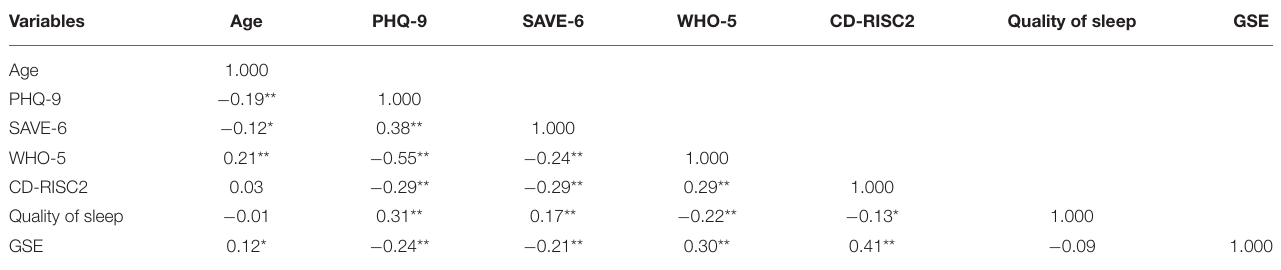
TABLE 2 | Spearman’s correlation coefficients of each variable in all subjects ( n = 406). Variables Age PHQ-9 SAVE-6 WHO-5